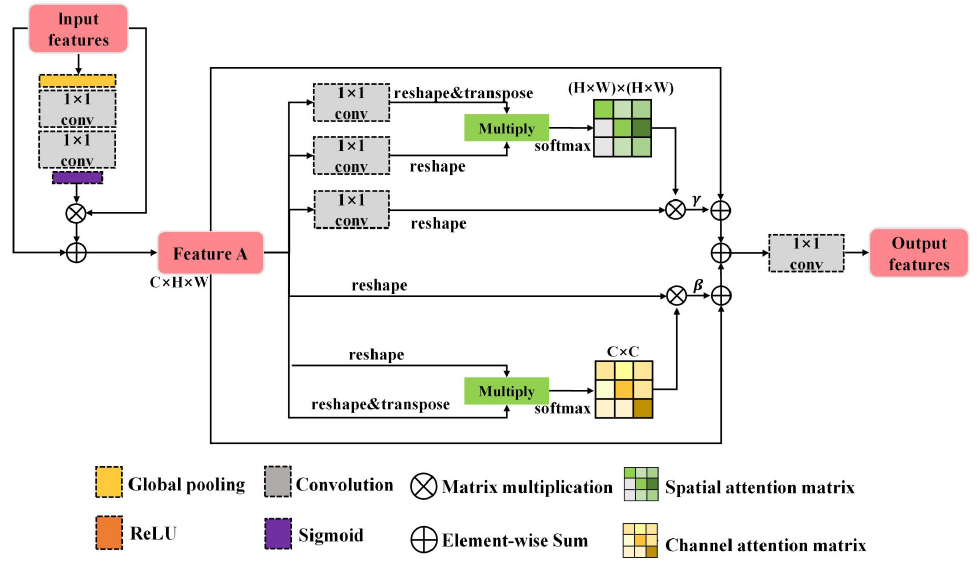
Figure 2. The architecture of Location